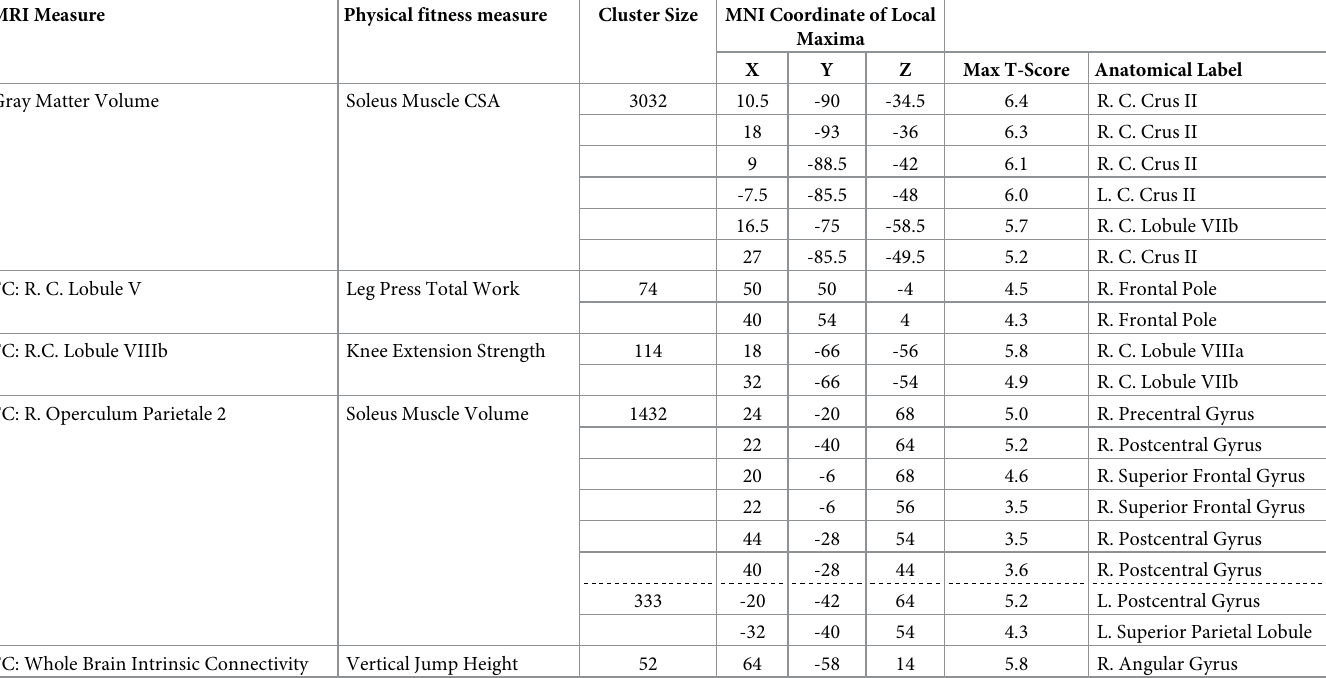
Table 2. Labels and peak coordinates of significant clusters from physical fitness correlational analysis. MRI Measure